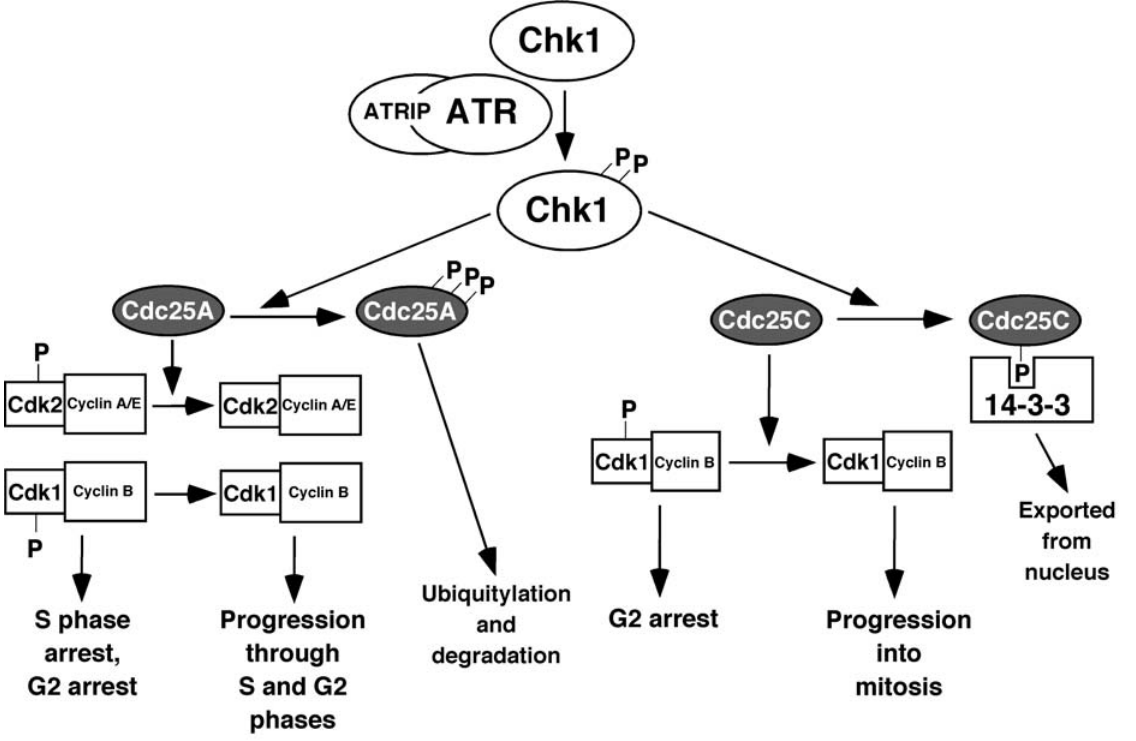
Figure 4. Chk1 mediates ATR-induced cell cycle arrest. ATR activates Chk1, which then phosphorylates and inactivates Cdc25A and Cdc25C. Phosphorylated Cdc25A is ubiquitylated and degraded, leaving Cdk2/cyclin complexes in their inactive form, resulting in S-phase and G2-phase arrest. Phosphorylated Cdc25C binds to 14-3-3 proteins and is exported from the nucleus, leaving Cdk1/cyclin B complexes in the inactive form, resulting in G2